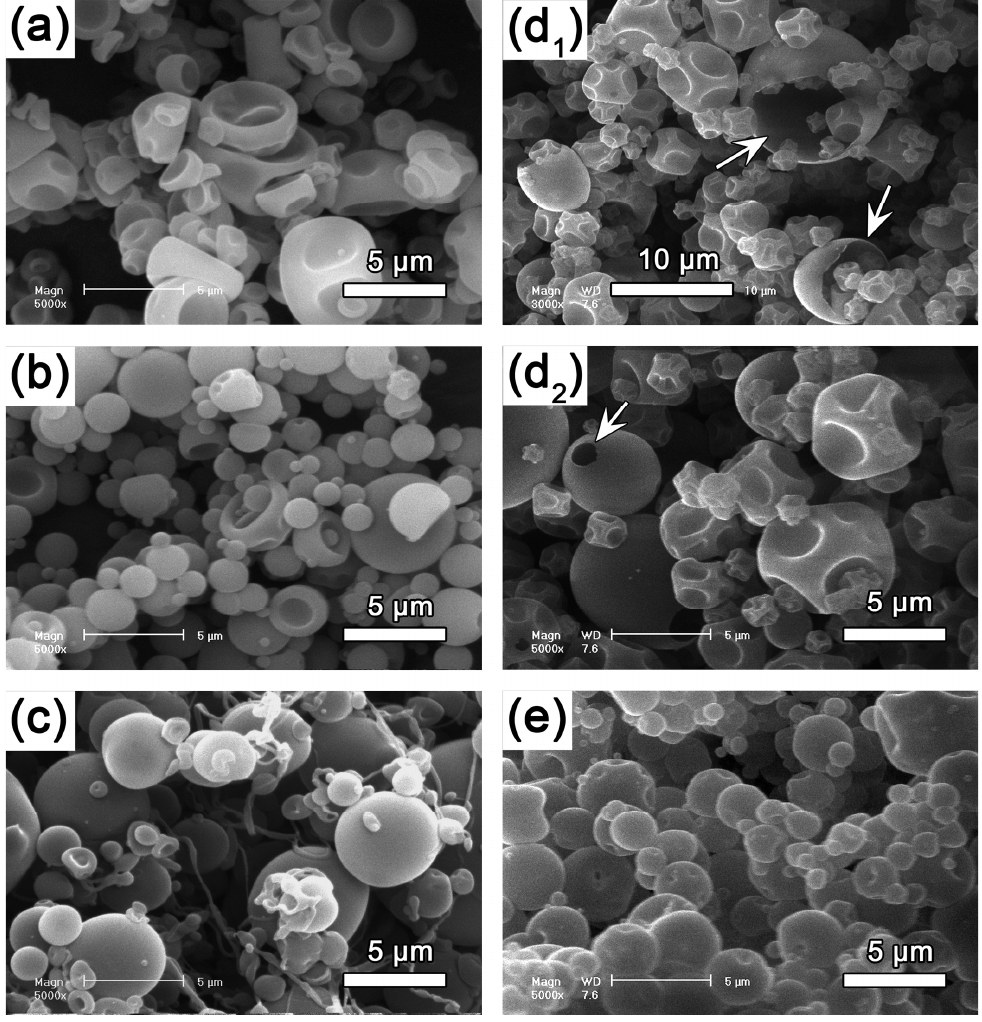
Figure 1. SEM pictures of microparticles of different materials and/or spray dried under different conditions. All powders, excepted the one shown in ( b ), are spray dried with the Büchi Mini Spray Drier B-290, in exactly the same operational conditions (inlet temperature: 150 °C, solution feed rate: 10 mL·min − 1 , aspiration rate: 100%), whereas sample ( b ) was obtained using a different apparatus, the Büchi Nano Spray Drier B-90 (with inlet temperature fixed at 100 °C feed rates at 10 mL·h − 1 , the drying gas flow rate equal to 100 L·min − 1 , and the spray mesh used in this study was the membrane with 4.0 μ m sized holes). ( a ) Gum Arabic at 10 wt.% in water (B-290). ( b ) Gum Arabic at 10 wt.% in water (B-90). ( c ) Polyvinyl Alcohol at 15 wt.% in water. ( d ) and ( d ) Hydroxypropyl 1 2 β -cyclodextrins (Kleptose ® HPB from Roquette, France) at 15 wt.% in water; arrows highlight particular structures due to high Pe discussed in the text. ( e ) Hydroxypropyl β -cyclodextrins (Kleptose ® HPB) at 15 wt.% in water, encapsulating